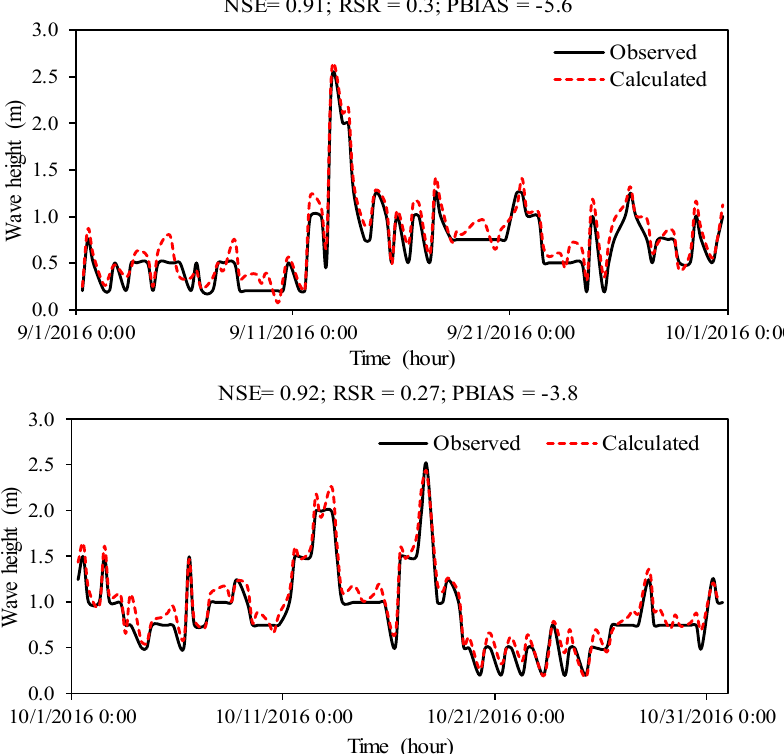
Figure 4. Calibration and validation of the wave height in 2D SW model at Ly Son station.